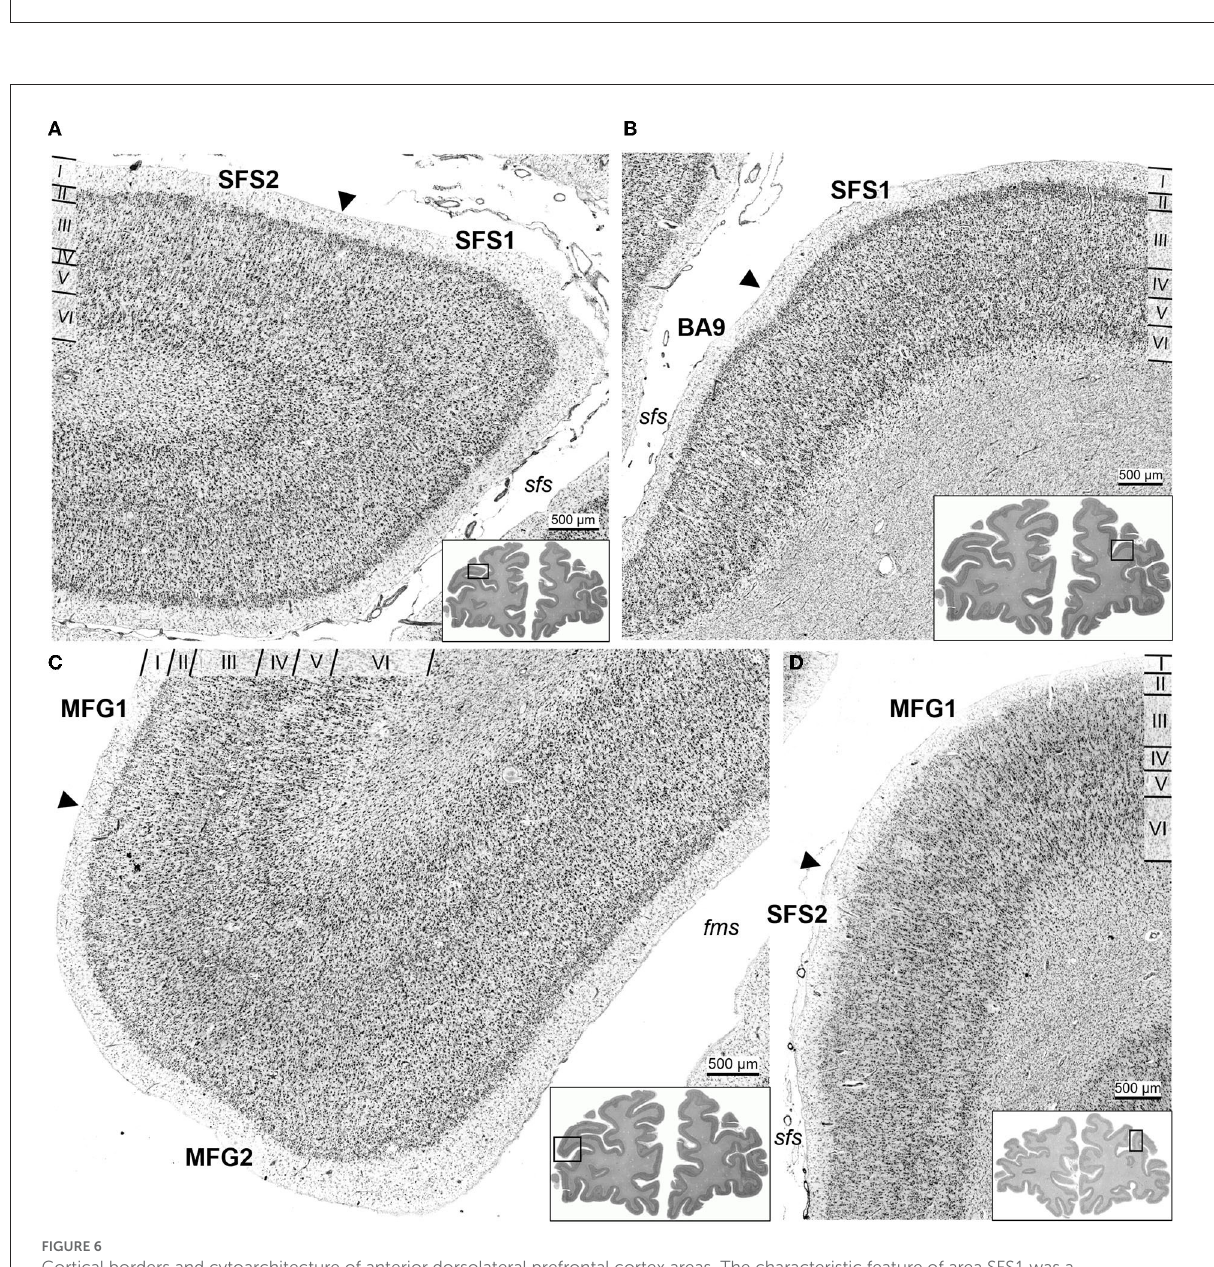
FIGURE6 Cortical borders and cytoarchitecture of anterior dorsolateral prefrontal cortex areas. The characteristic feature of area SFS1 was a well-developed layer IV and a rather uniform appearance in general, due to similar cell density and size overall layers, compared to area SFS2 (A) and BA9 (B) . Area MFG1 had large pyramidal cells in deeper layer III and broad infragranular layers V and VI. In contrast, layers III and V of area MFG2 consisted of homogenous medium-sized cells and thin infragranular layers (C) . Area SFS2 had a loosely packed layer III, and a thin and blurred layer IV compared to SFS1 (A) and MFG1 (D) . Arrowheads indicate the respective cortical borders. Sulci labeled in italic ( sfs , superior frontal sulcus; fms , frontomarginal